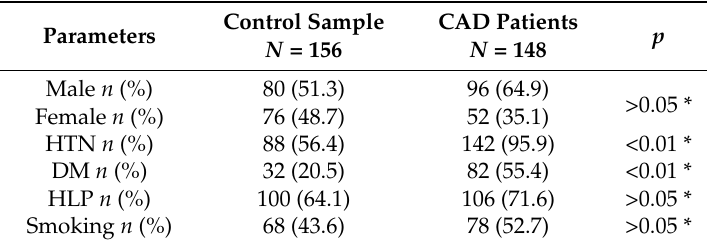
Table 1. Demographic and risk factor frequencies.